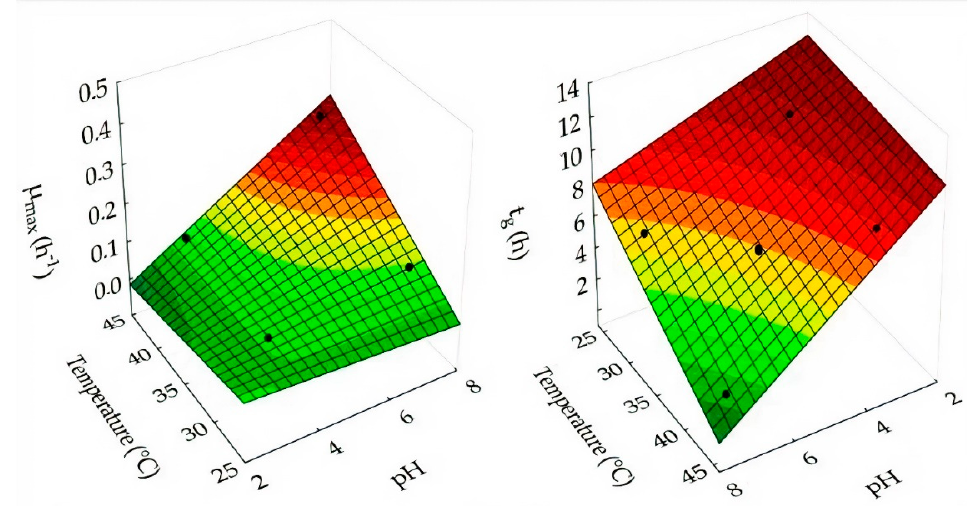
Figure 2. Effect of incubation pH and temperature on maximum growth rate and generation time of L. gasseri in passion fruit juice.